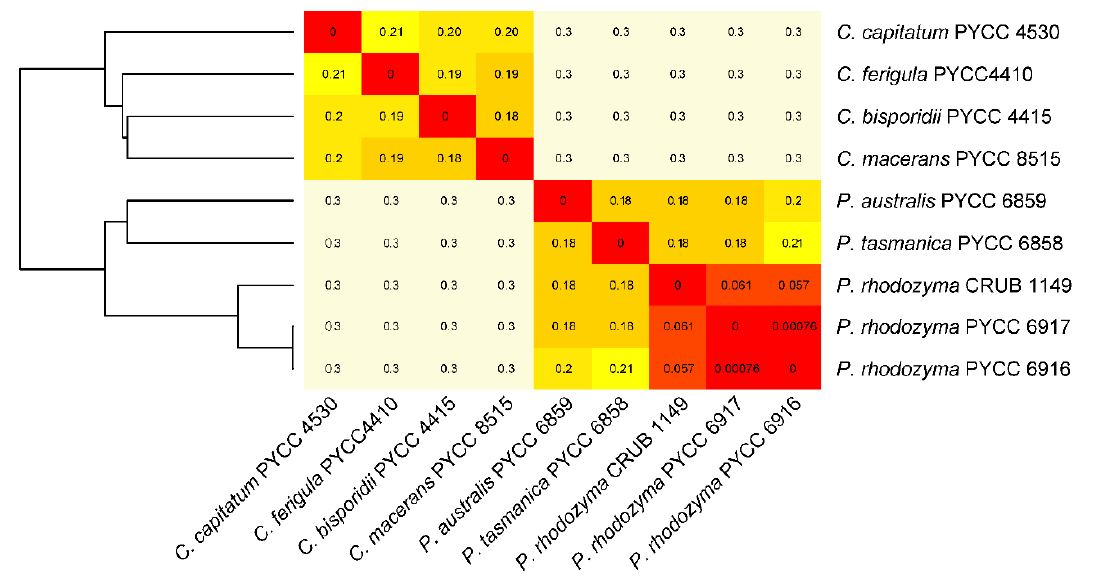
Figure 2. Pairwise divergence using the Kr alignment-free method between the three Pha ffi a ( P .) species and comparison with four species of Cystofilobasidium ( C .). Heat-map of divergence values (red, lowest divergence; pale yellow, highest divergence). The dendrogram on the left was based on Euclidean distances and average clustering.